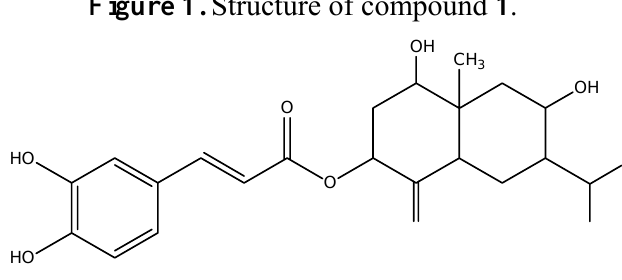
Figure 1. Structure of compound 1